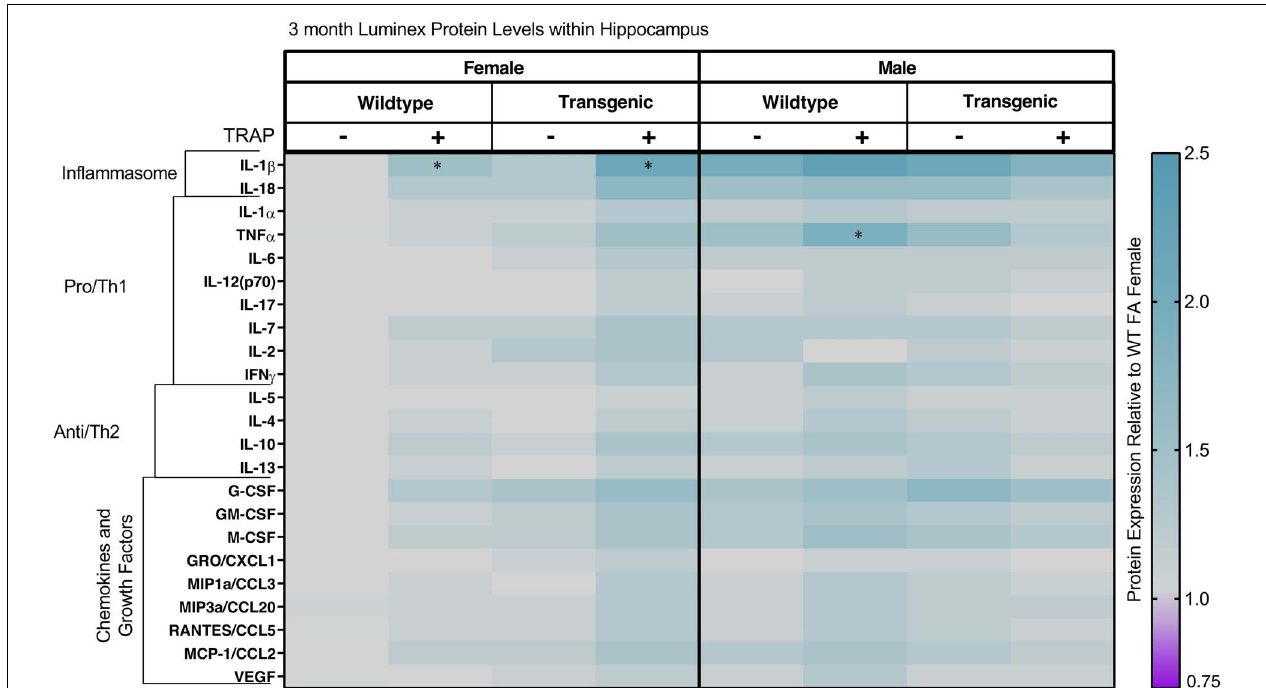
FIGURE 6 | Heat map representation of hippocampal cytokine, chemokine, and growth factor changes in response to TRAP in 3-month old TgF344-AD and WT rats. Hippocampal levels of cytokines and growth factors in TgF344-AD and WT rats exposed to FA or TRAP for 2 months were analyzed using multiplex technology. For each analyte, individual values were normalized to the mean level of that same analyte in hippocampal tissue from female FA WT animals. Purple indicates normalized protein levels < 1.0; turquoise indicates normalized protein levels > 1.0. ± indicates exposure with + identifying TRAP-exposed animals; - indicating FA-exposed animals; n = 4–5 animals per group (duplicate samples were analyzed for each animal). ∗ Significantly different from sex-matched WT FA control at p < 0.05 as determined by post hoc Sidak’s test. Non-normalized cytokine values for female WT animals are provided in Supplementary Table 2